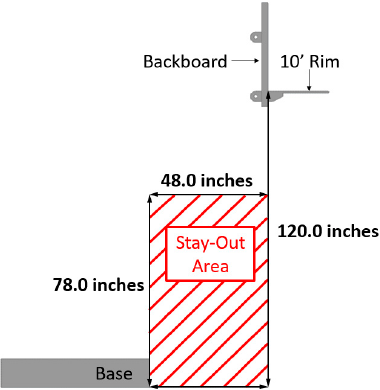
Figure 1. Base and backboard with a rim height of 120” (10 ft.) and “safe” 48” × 78” clearance area.